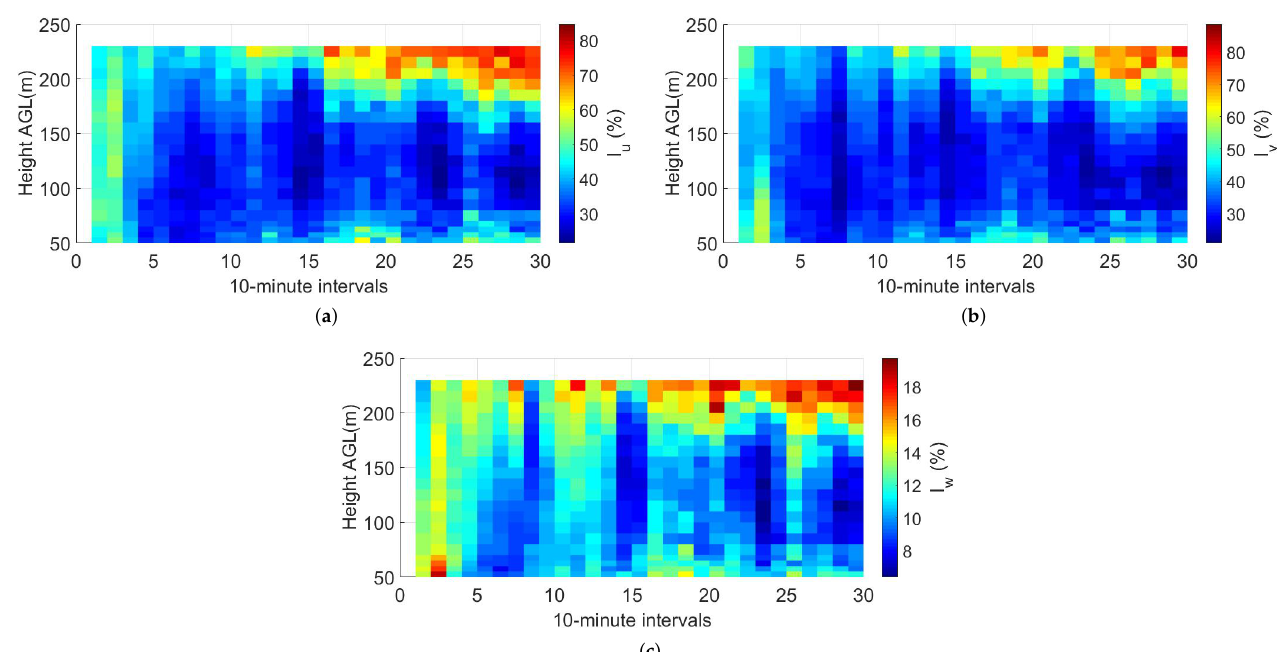
Figure 7. Time evolution of turbulence intensity for 21 different heights AGL, in the along-wind ( a ), lateral ( b ) and vertical ( c ) direction during wind episode 5 on 4 December 2019.